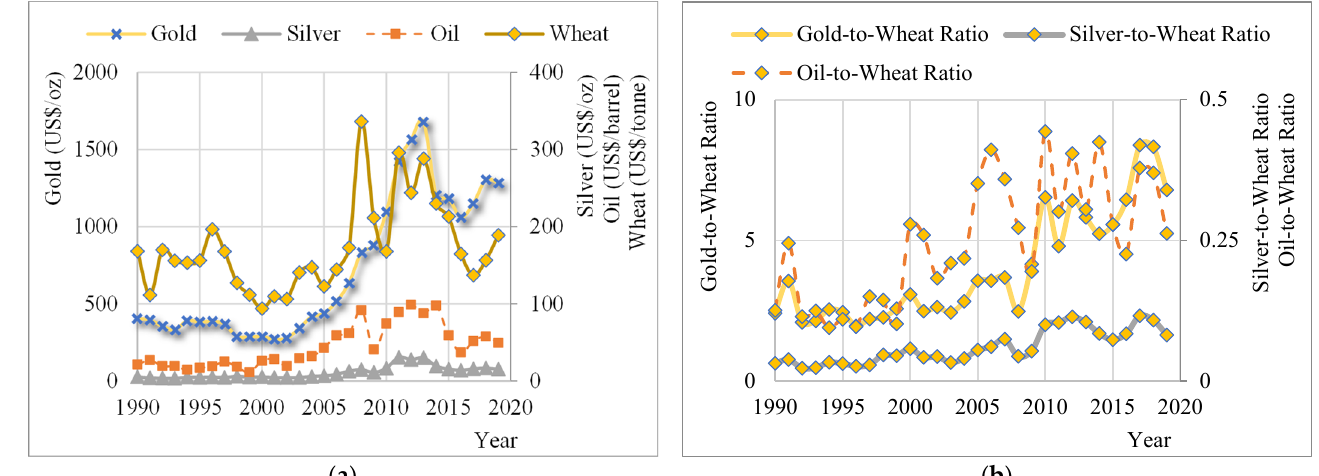
Figure 8. ( a ) Values of gold, silver, oil and wheat, ( b ) Gold to wheat ratio, silver to wheat ratio, oil to wheat ratio [29,30,46].